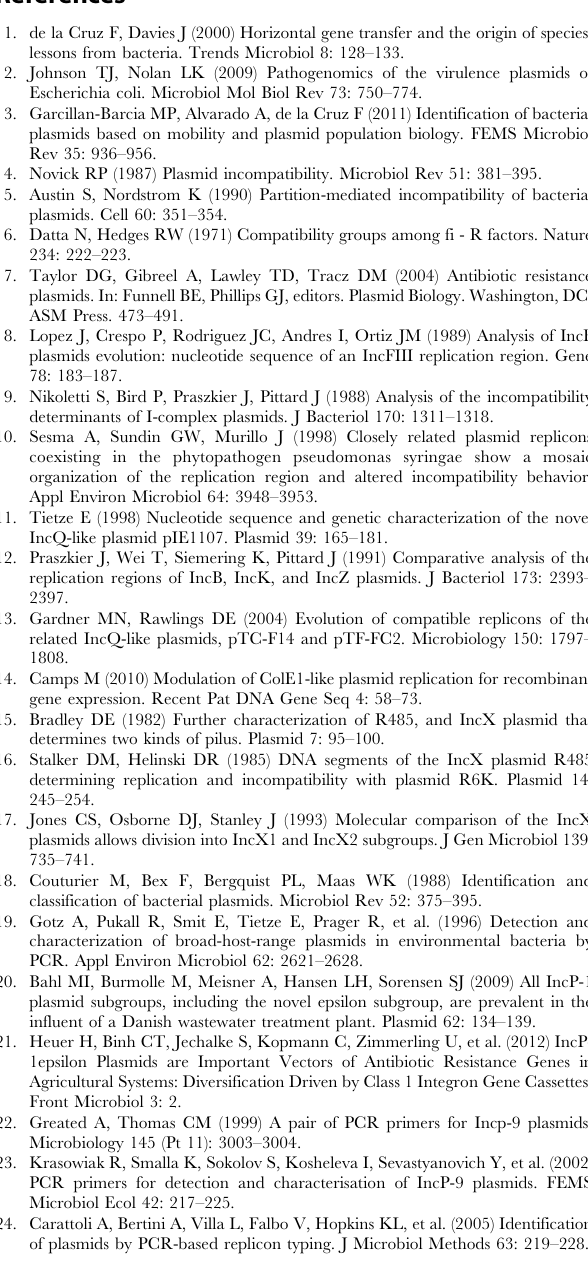
Table S1 Plasmids from c -Proteobacteria contained in the NCBI